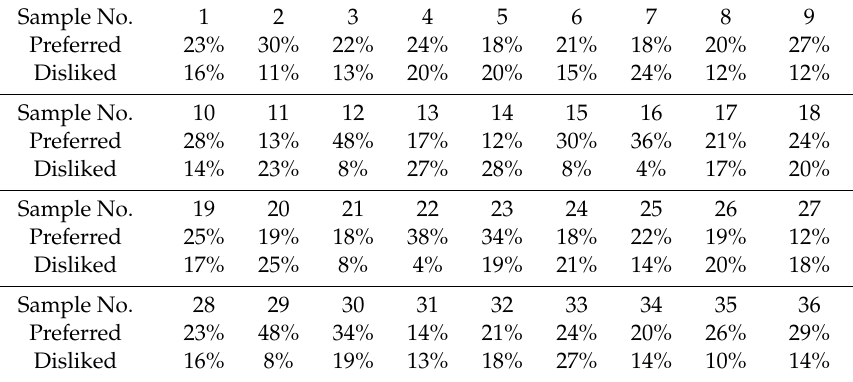
Table 1. Percentages of consumers favoring and disliking each yogurt sample.